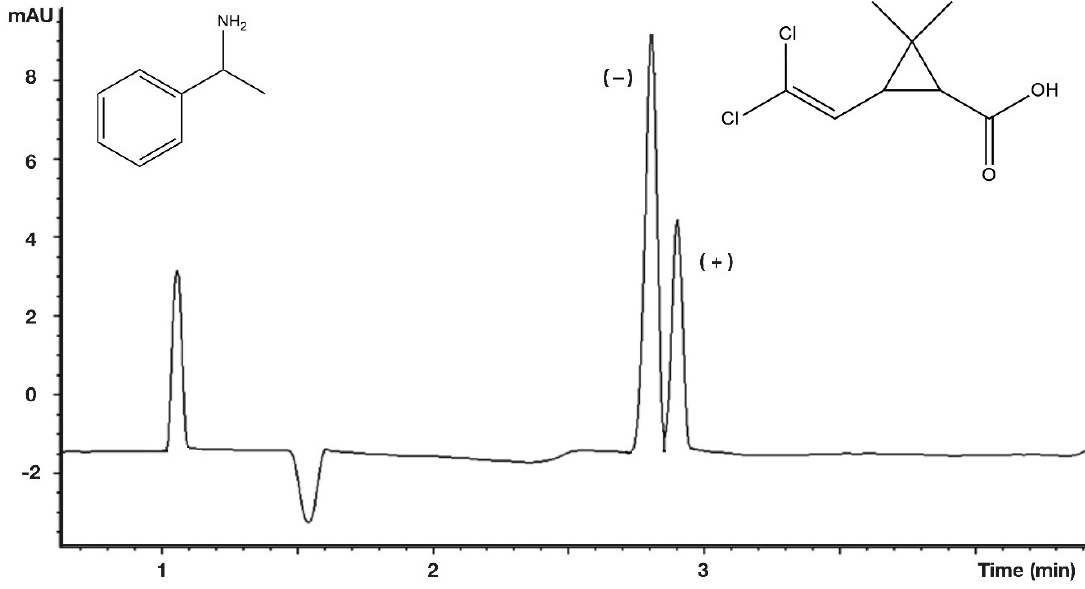
Figure 10. Electropherogram of raffinate of a diastereomeric salt resolution. Conditions: instrument, 33.5/25 cm × 50 μ m column, FSOT; voltage, 20 kV; detection, 210 nm; temperature, 25 °C; buffer, 50 mM BRB, pH 7.0; chiral selector, 10.0 mM TRIMEB.